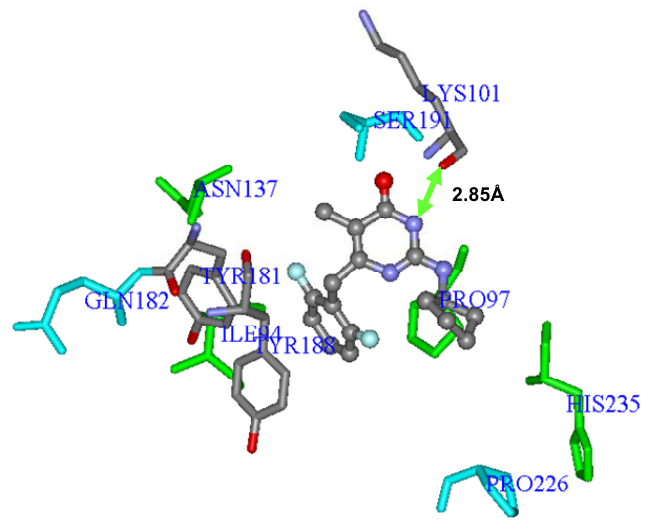
Figure 7. Three-dimensional graphic representation of Eq.E (Tables 3 and 4, DB-I ), using the most potent NH-DABO, compound 59 (stick-and-ball model colored by element), highlighting the frequently mutated residues Lys101 , Tyr181 , and Tyr188 (stick model colored by element). The arrow indicates a possible hydrogen interaction between 59 and Lys101 . The residues (stick model) colored in green ( Ile94 , Pro97 , His235 , and Asn137 ) and by element ( Lys101 , Tyr181 , and Tyr188 ) represent Lennard-Jones contributions and those colored in light blue ( Gln182 , Ser191 , and Pro226 ) represent Coulomb contributions. The hydrogen atoms were omitted for better